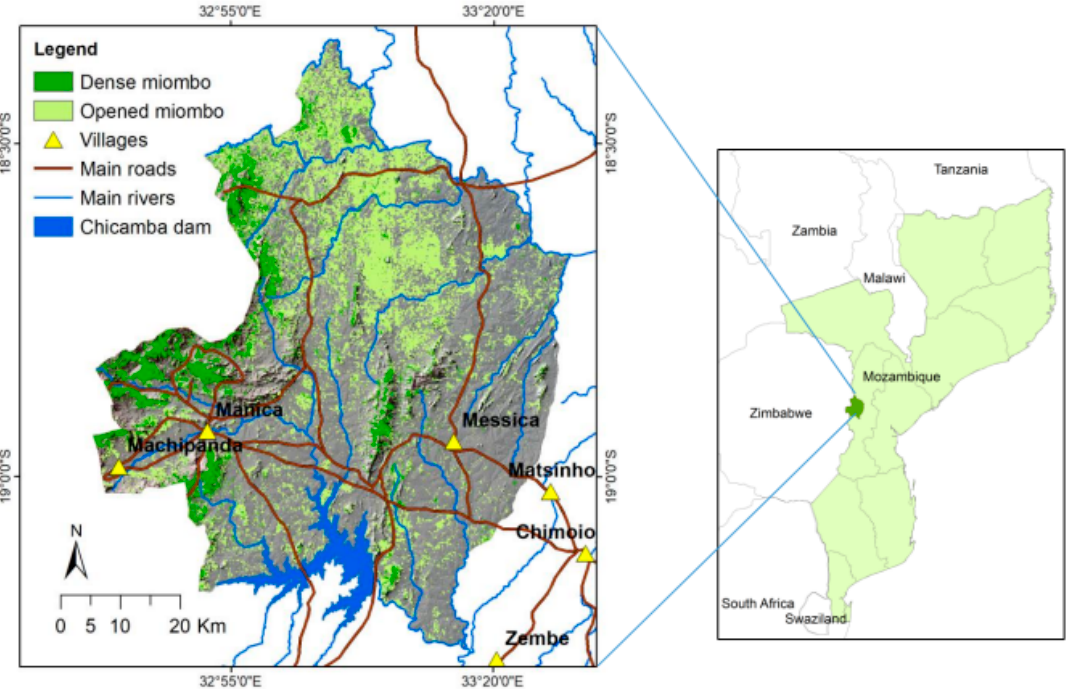
Figure 1. Location of the study area, in the center of the country, showing the distribution of dense and open miombo woodlands. Land use and land cover data source: Ministry of Land, Environment and Rural Development [13].